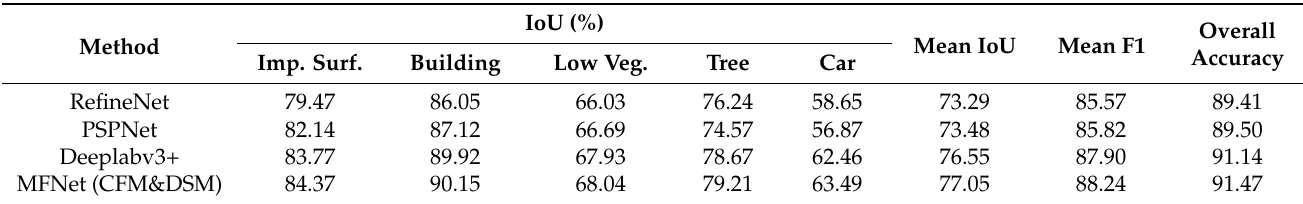
Table 2. Vaihingen dataset object accuracy.